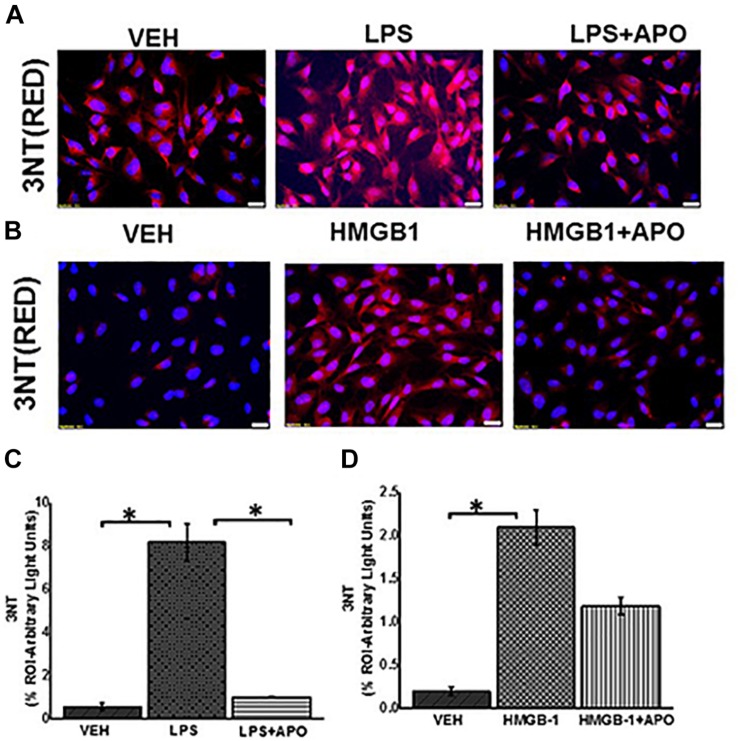
Peroxynitrite formation in EGC. (A,B) Expression of 3NT in rat EGC (n = 6). Immunoreactivity of 3NT was detected in vehicle (VEH), LPS, LPS + APO, HMGB-1 and HMGB-1 + APO treated cells by staining with red fluorescent antibody and counterstained with DAPI (blue) viewed at total magnification 400X; scale 20 μm). (C,D) Morphometric analysis of 3NT in rat EGC per 100 cells in different fields (∗P < 0.05).